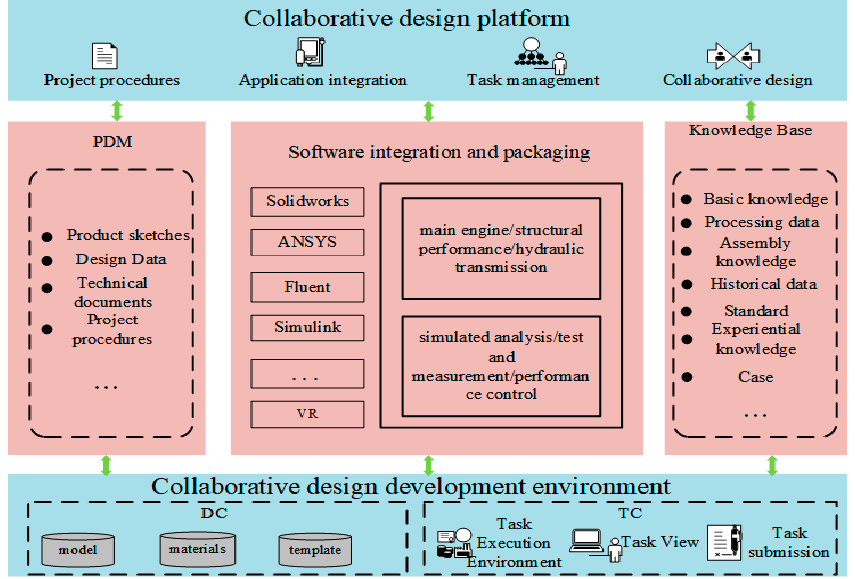
Figure 4. Intelligent collaborative design platform for complex products.